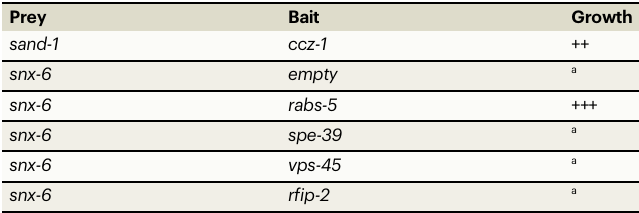
Table 1 | Y2H (yeast-two-hybrid)